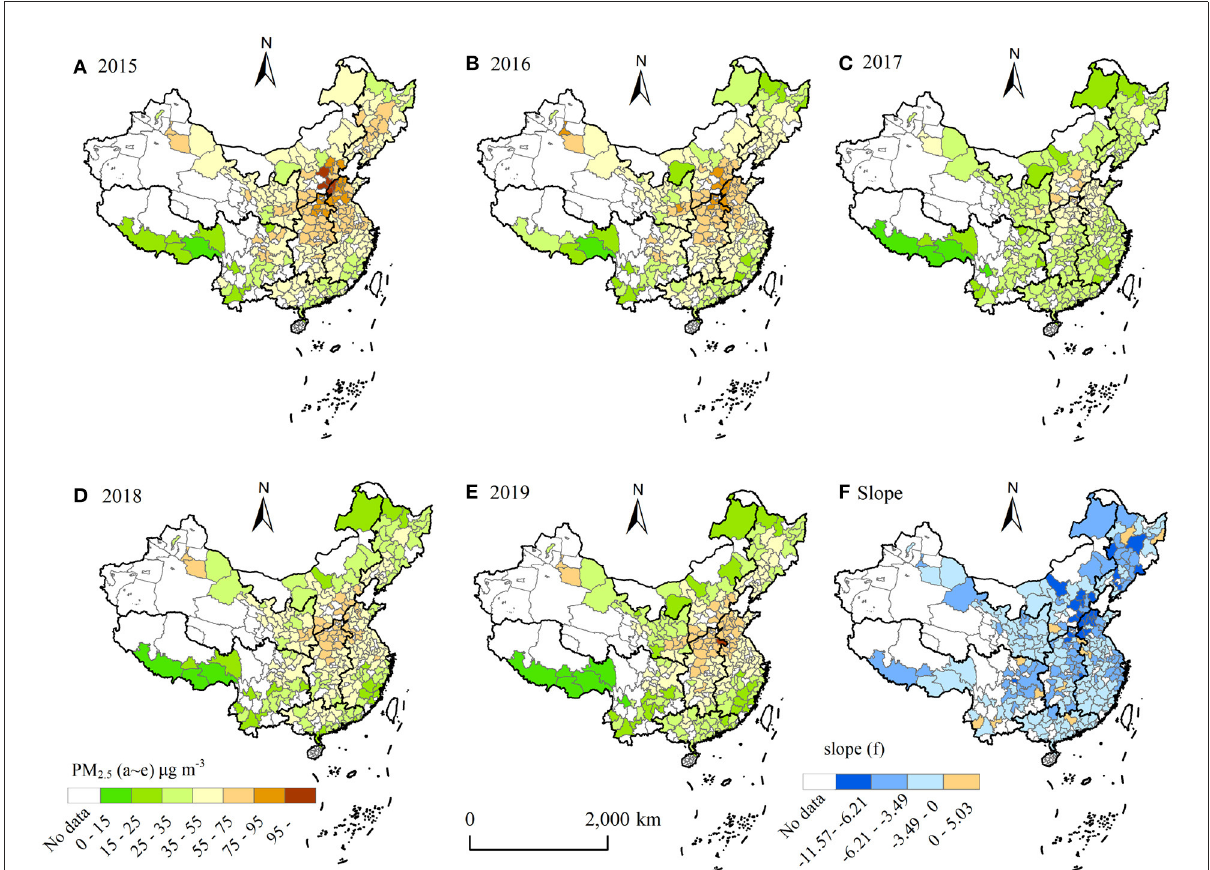
FIGURE2 Spatial variation characteristics of PM 2.5 concentrations during 2015-2019 [ (A–E) denote the spatial distribution of PM 2.5 concentrations in 2015, 2016, 2017, 2018, and 2019, respectively, and (F) denotes the slope of PM 2.5 concentrations from 2015 to 2019, slope (5-year linear trend